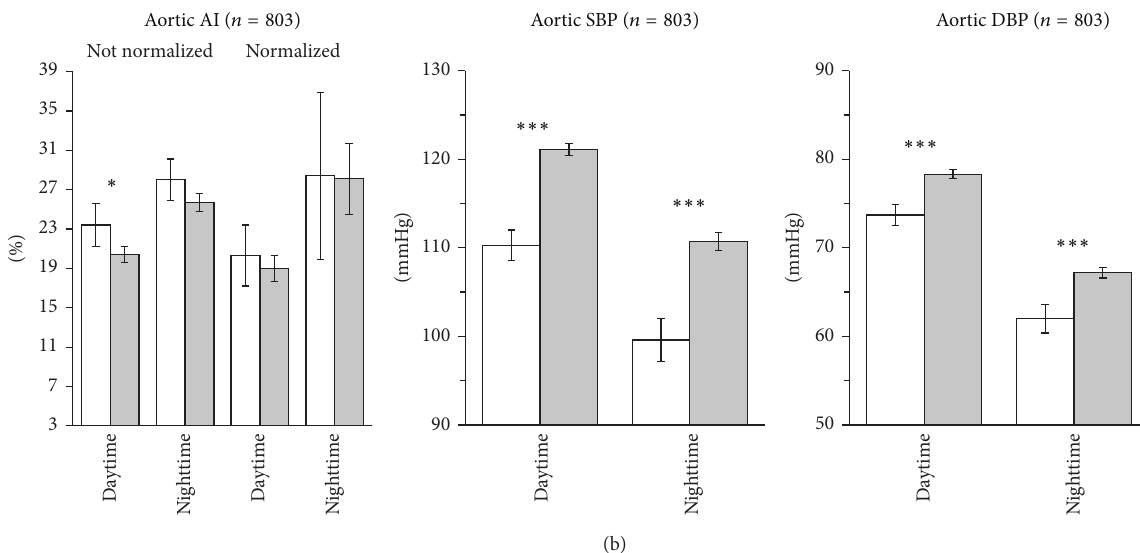
Figure 1: Daytime and nighttime reflected wave transit time (RWTT), aortic pulse wave velocity (PWV), peripheral and aortic augmentation index (AI), and central (aortic) systolic (SBP) and diastolic blood pressure (DBP) values in healthy controls (open bars) and hypertensive patients (gray bars). For RWTT, PWV, and AI not normalized and normalized data (corrected for SBP and/or heart rate) are represented. Data are shown as averages and 95% confidence intervals for crude estimates (a) and for adjusted estimates ((b) data adjusted by age, gender, body mass index, antihypertensive treatment, and 24-hour SBP and DBP). The asterisks indicate the level of the statistical significance of the difference between the two study groups ( ∗∗∗ 𝑃 < 0.001 ; ∗∗ 𝑃 < 0.01 ; ∗ 𝑃 < 0.05